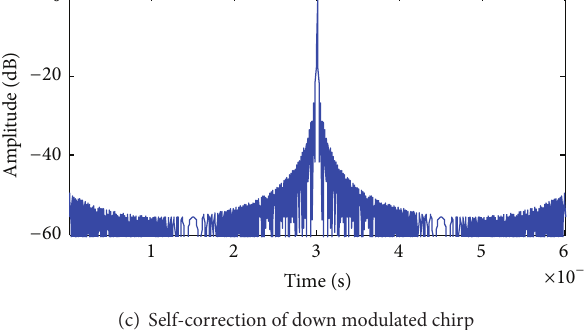
(c) Self-correction of down modulated chirp Figure 6: Correction between transmitted chirp